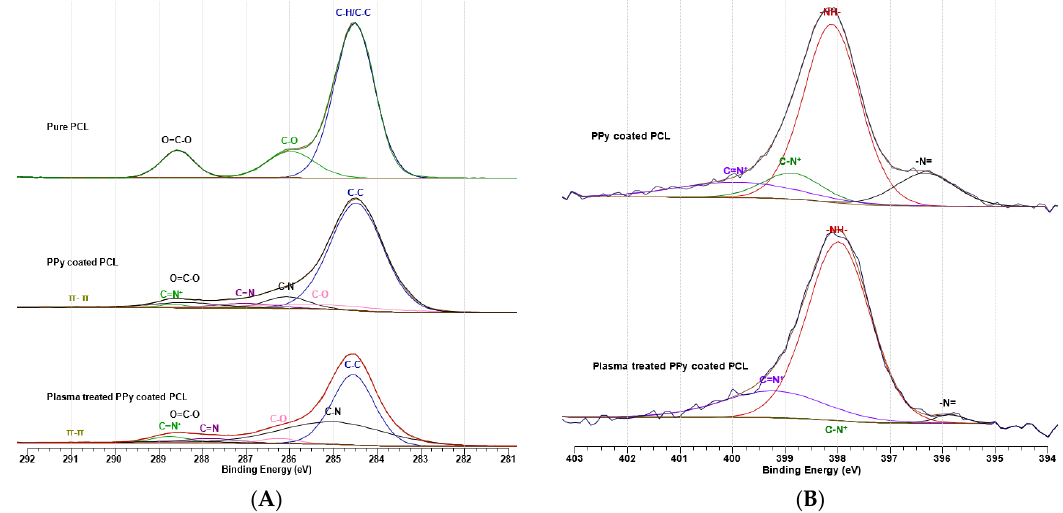
Figure 5. High-resolution XPS spectra of the coated and uncoated samples at C 1 s, and comparison of the coated samples without and with plasma treatment at N 1 s. ( A ) High-resolution C 1 s spectrum for PCL and PPy-coated PCL fibers without and with plasma treatment; ( B ) High-resolution N 1 s spectrum for PPy-coated PCL fibers without and with plasma treatment.